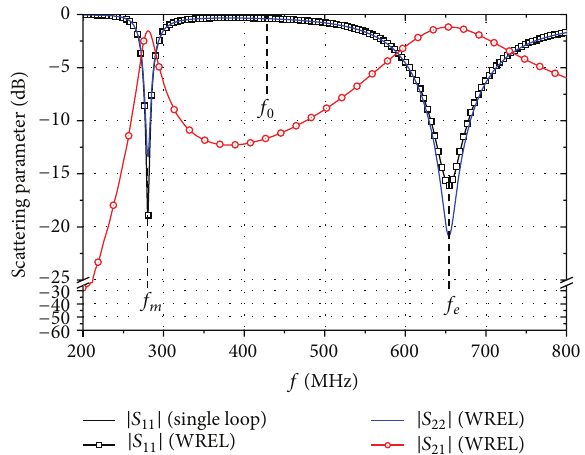
Figure 3: Simulated reflection coefficient of the single loop com- pared to the scattering parameters of the WREL consisting of two loops configured as in Figure 2(a).